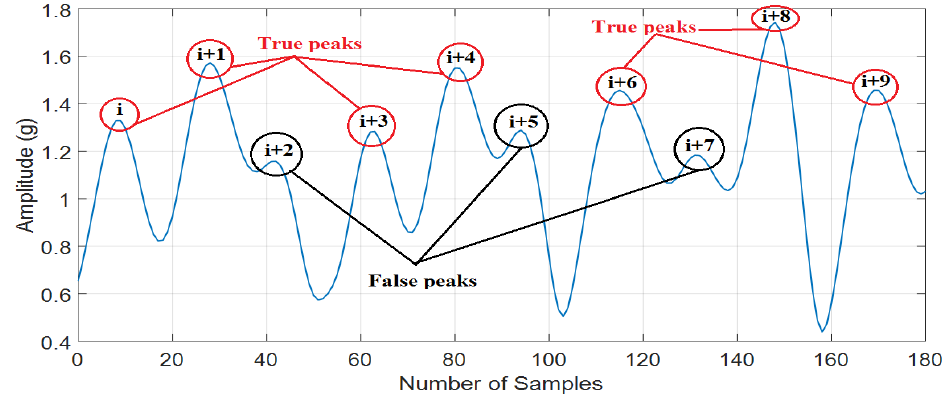
Figure 6. The true peaks and the false peaks of a data sample.